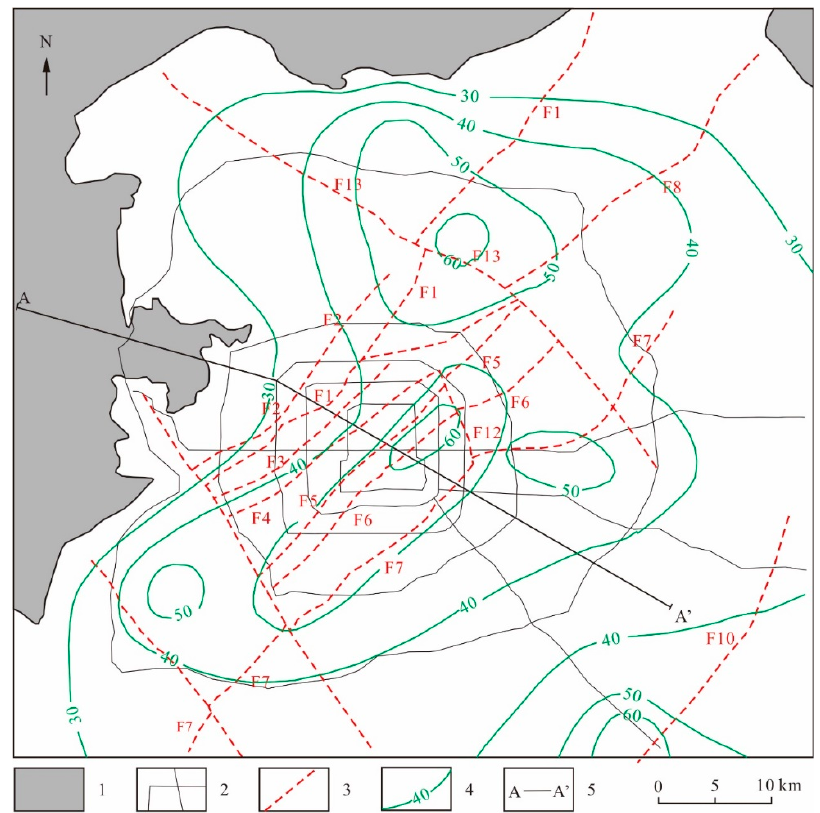
Figure 5. Contour map showing the temperature at the elevation of − 2000 m in the Beijing plain area. 1—Mountainous area; 2—Main roads in Beijing; 3—Fault; 4—Temperature contour; 5—Horizontal position of A–A’ section. Table 2. Geotemperature gradient of di ff erent strata. Average Geothermal Formation Strata Formation Symbol Strata Symbol